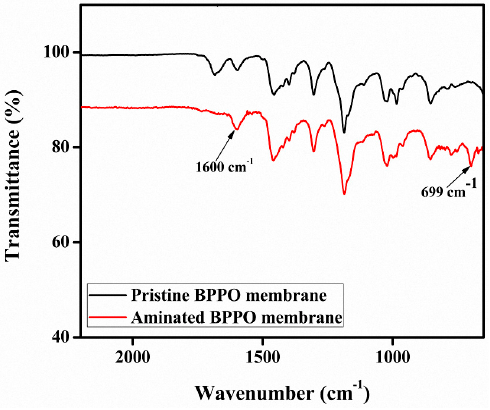
Figure 2. IR spectrum of BPPO-based AEMs.